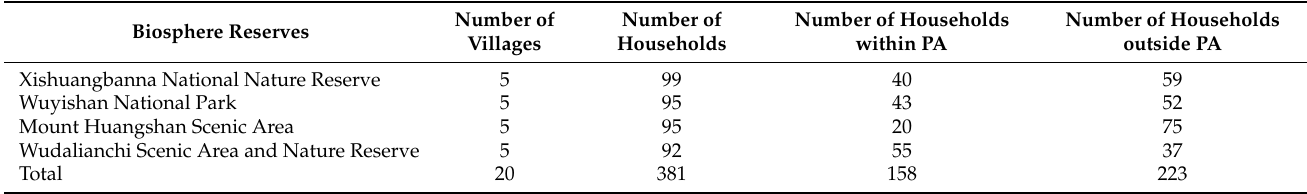
Table 1. Sample distribution in this study.